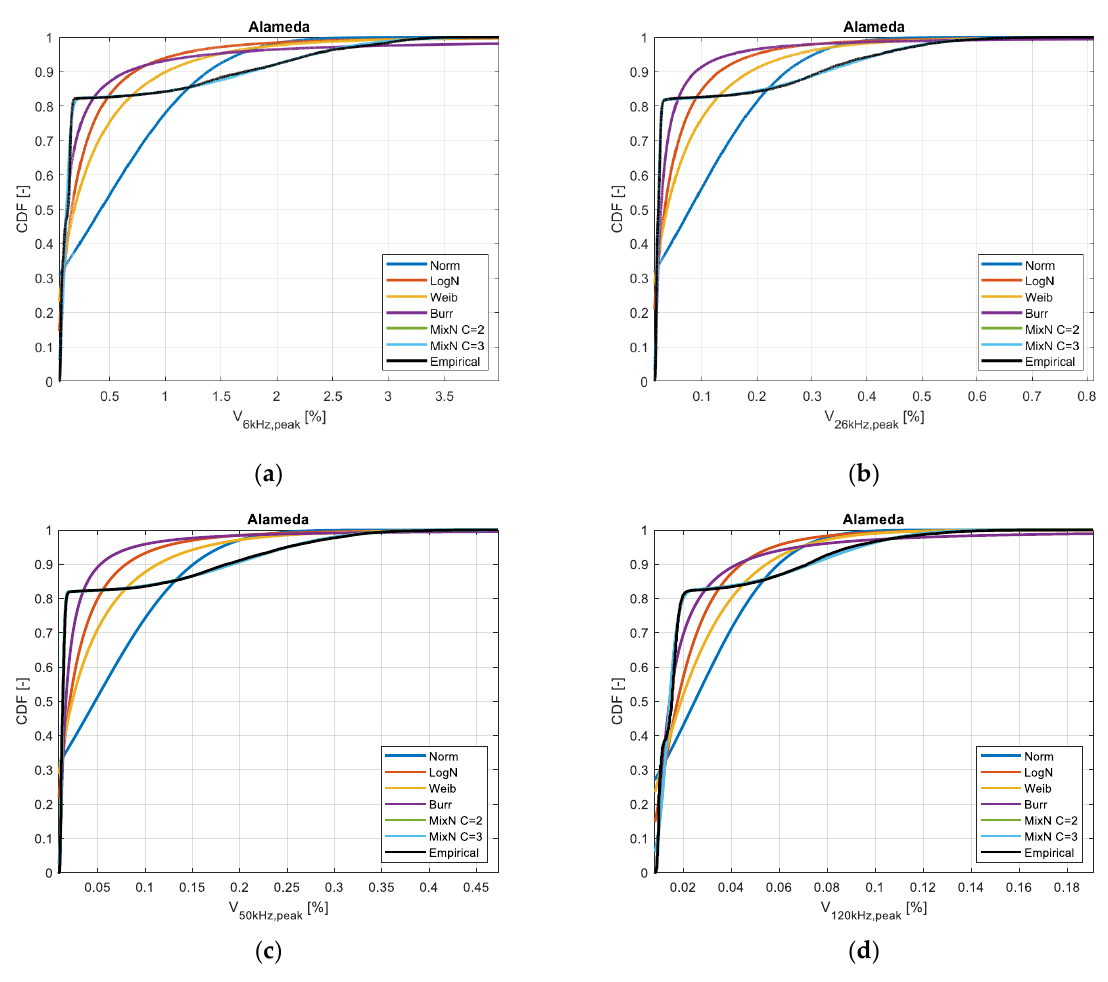
Figure 4. Estimated and empirical CDFs of the: ( a ) 6-kHz; ( b ) 26-kHz; ( c ) 50-kHz; ( d ) 120-kHz peak voltage component at Alameda (CA).